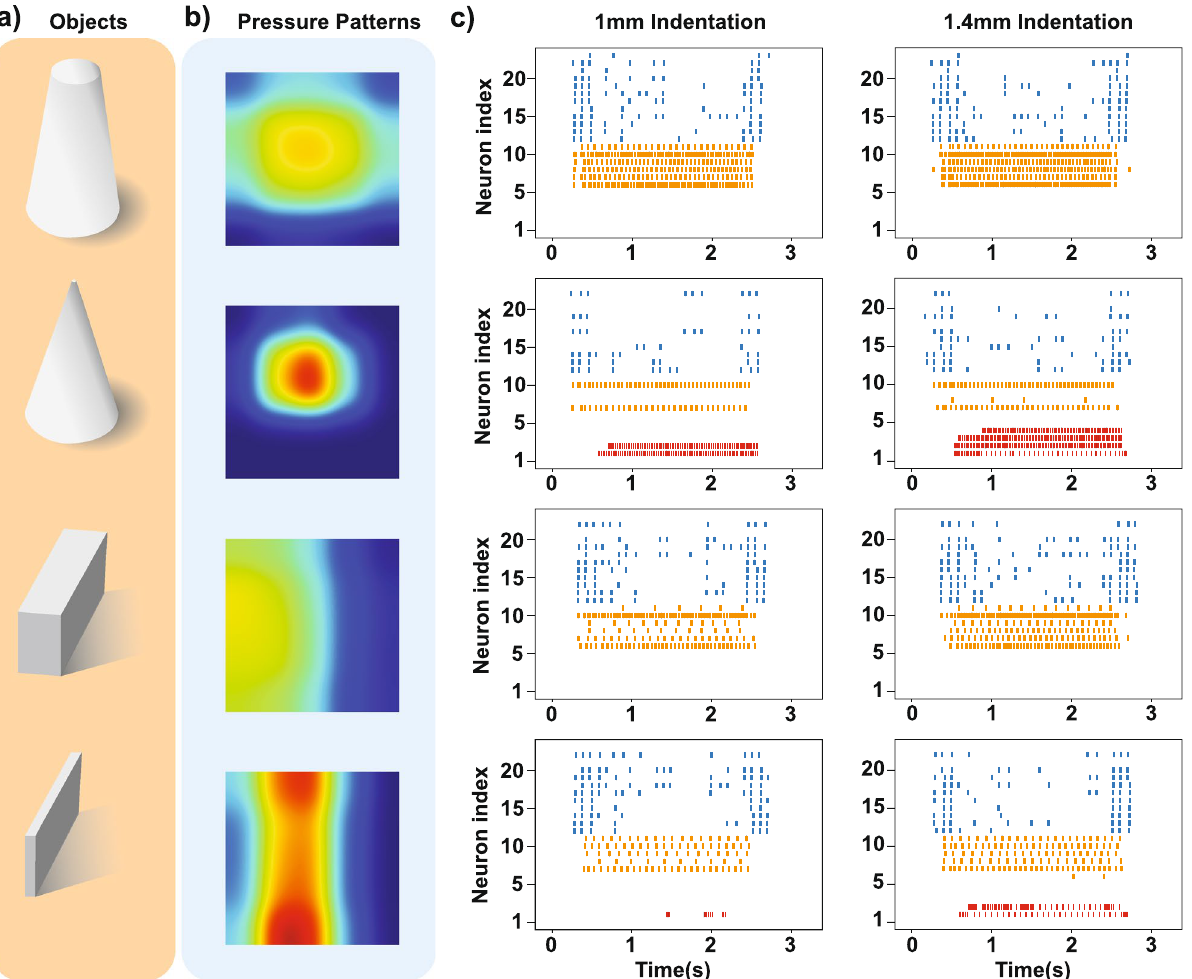
Figure 4. Responses of the bio-inspired SA-I/RA-I/nociceptors circuits to different objects. ( a ) Two different groups of objects with two different levels of sharpness are used to elicit responses. ( b ) Pressure pattern of the tactile sensor during indentation of each object by the custom-built robotic system. ( c ) Spiking activity of the bio-inspired afferents (RA-I (blue), SA-I (orange)) and bio-inspired nociceptor (red) for two levels of indentation (1 and 1.4 mm). As the object sharpness is increased, the spiking responses of the digital circuits of the SA-I/RA-I are decreased while firing patterns of the bio-inspired nociceptors are lar spiking and fast spiking modes of the Izhikevich model, respectively. The dynamics are chosen to functionally adapt to the biological behavior of the SA-I/RA-I and free nerve endings 37 . When an object is touched by the tac- tile sensor array, a higher number of active taxels indicate a larger distribution of the pressure on the artificial fin- gertip, which is considered as an innocuous (non-painful) tactile stimuli. On the other hand, activating a lower number of taxels with high pressure is assumed as a noxious touch. Two cones and two cubes from Group-I and -II are shown in Fig. 4a. The activation patterns of the tactile sensor are illustrated in Fig. 4b when the objects are touched. The bio-inspired afferents/nociceptors which have been implemented on the FPGA encode the tactile stimuli in the spatiotemporal pattern of spiking activity. Figure 4c shows the spike responses recorded from the FPGA for two different indention profiles. Generally, deeper indention (stronger contact) leads to an increase in the firing rate. As can be seen in Fig. 4c, the nociceptors (neuron #1-5 shown in red) strongly respond to the sharper objects. Next, we investigate the contribution of each afferent/nociceptor, in sharpness detection. The results are illustrated in Fig. 5 for the spike count algorithm. The synergy between digital nociceptors and digital SA-I afferents shows better sharpness recognition compared to the collaboration between digital nociceptors and digital RA-I afferents (Fig. 5a,c). This may be caused by the inherent characteristics of the RA-I afferents which respond to the transient phase of contact (onset and offset of contact). In our experiment, the object indents into the sensor and remains unchanged until the end of the trial, hence, the RA-I afferents are silent during the holding phase (Fig. 4c). On the other hand, SA-I afferents provide consistent responses during the onset, hold phase, and offset of each trial (Fig. 4c). The mean firing rate of each bio-inspired SA-I/RA-I/nociceptor circuit is depicted in Fig. 5b,d. Interestingly, it shows that the sharper objects decrease the firing activity of bio-inspired SA-I/RA-I, while, increase the firing responses of the bio-inspired nociceptors. This is because of the involving fewer taxels for sharper objects.